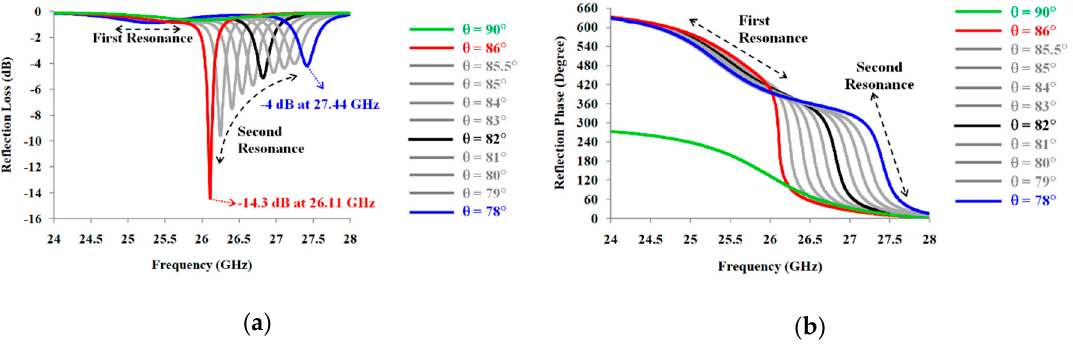
Figure 2. Simulated frequency response of the asymmetric patch element with variable inclination angle and full ground plane: ( a ) Reflection loss; ( b ) Reflection phase.